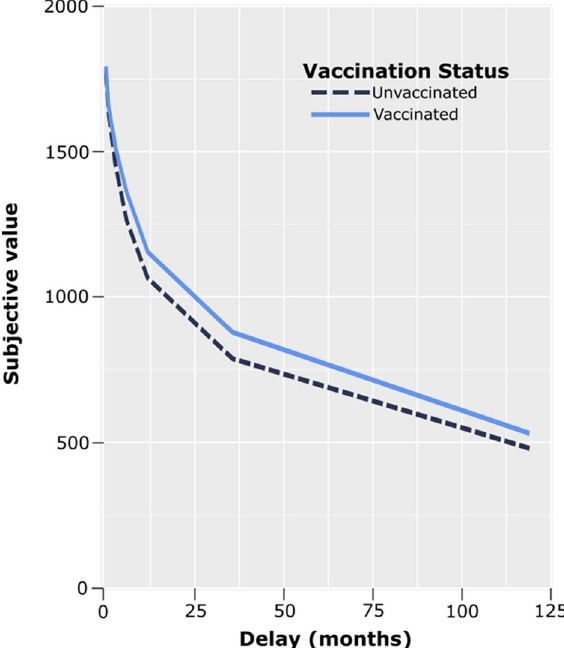
Figure 2. Discounting curves in vaccinated and unvaccinated participants. Subjective value (mean indifference point) of the $2,000 delayed reward as a function of the delay to its receipt. Area-under-the-Curve (AuC) was used as a measure of delay discounting. Unvaccinated individuals on average tended to discount future rewards more steeply (i.e., have smaller AuCs) than vaccinated